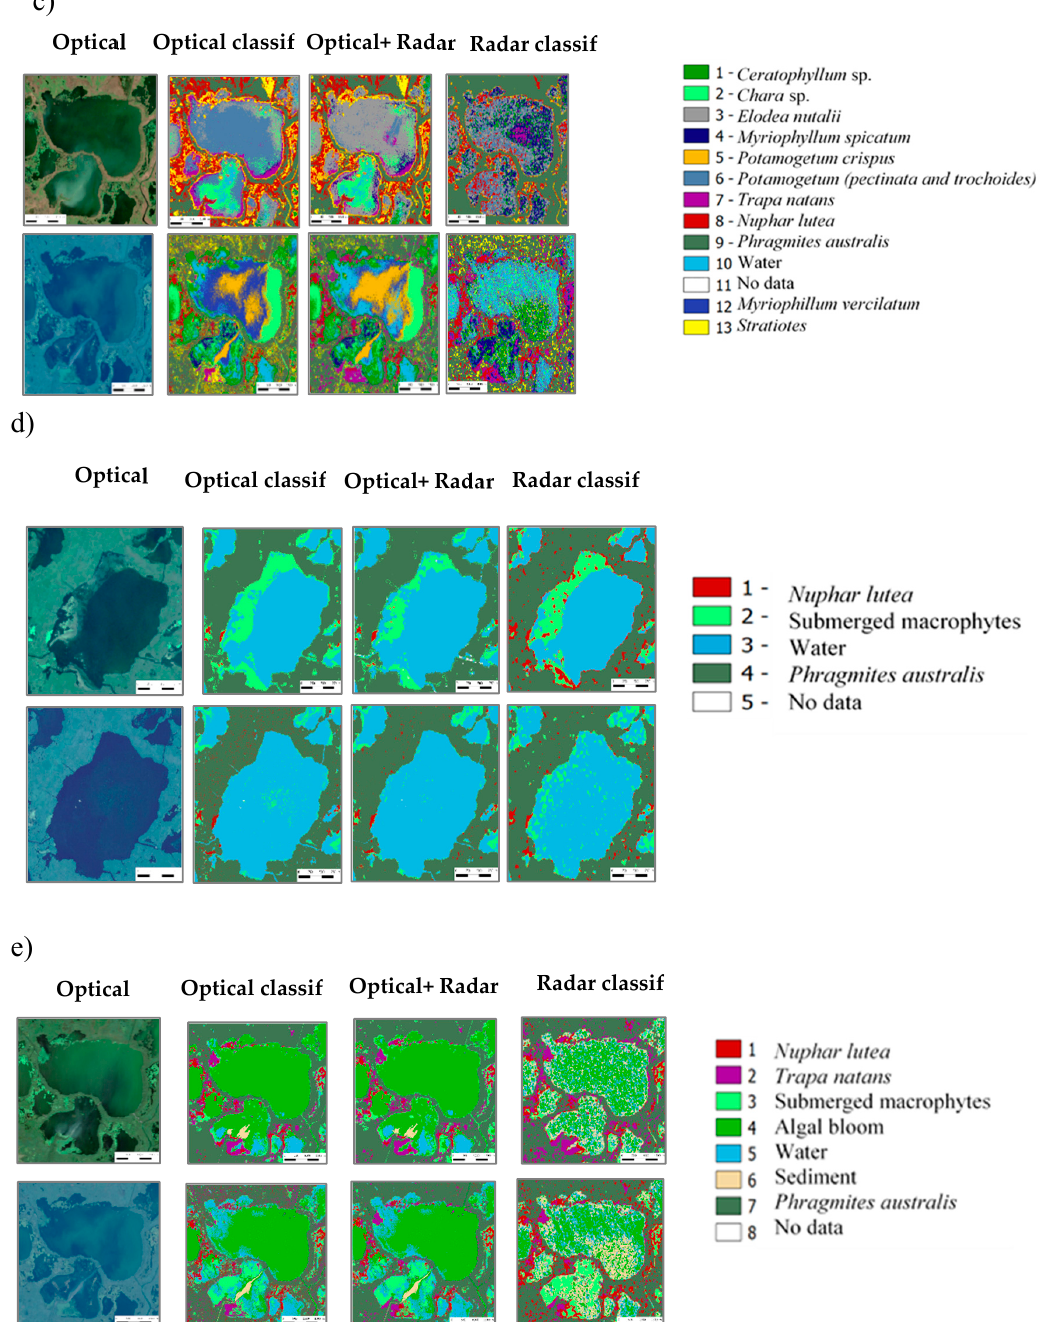
Figure 11. ( a ) Localization of the detailed view of two lakes in the two zones. Comparisons of classification with detailed nomenclature: ( b ) north classifications / detailed nomenclature (10 classes) ( c ) south classifications / detailed nomenclature (13 classes). S2 used: 07 / 17 / 2016, bands and indices and Pleiades used: 07 / 11 / 2017, bands and indices. Comparisons of classification with simple nomenclature. ( d ) North classifications / simple nomenclature (5 classes). S2 used: 08 / 06 / 2016, bands and indices. Pleiades used: 07 / 11 / 2017, bands and indices. ( e ) South classifications: simple nomenclature (8